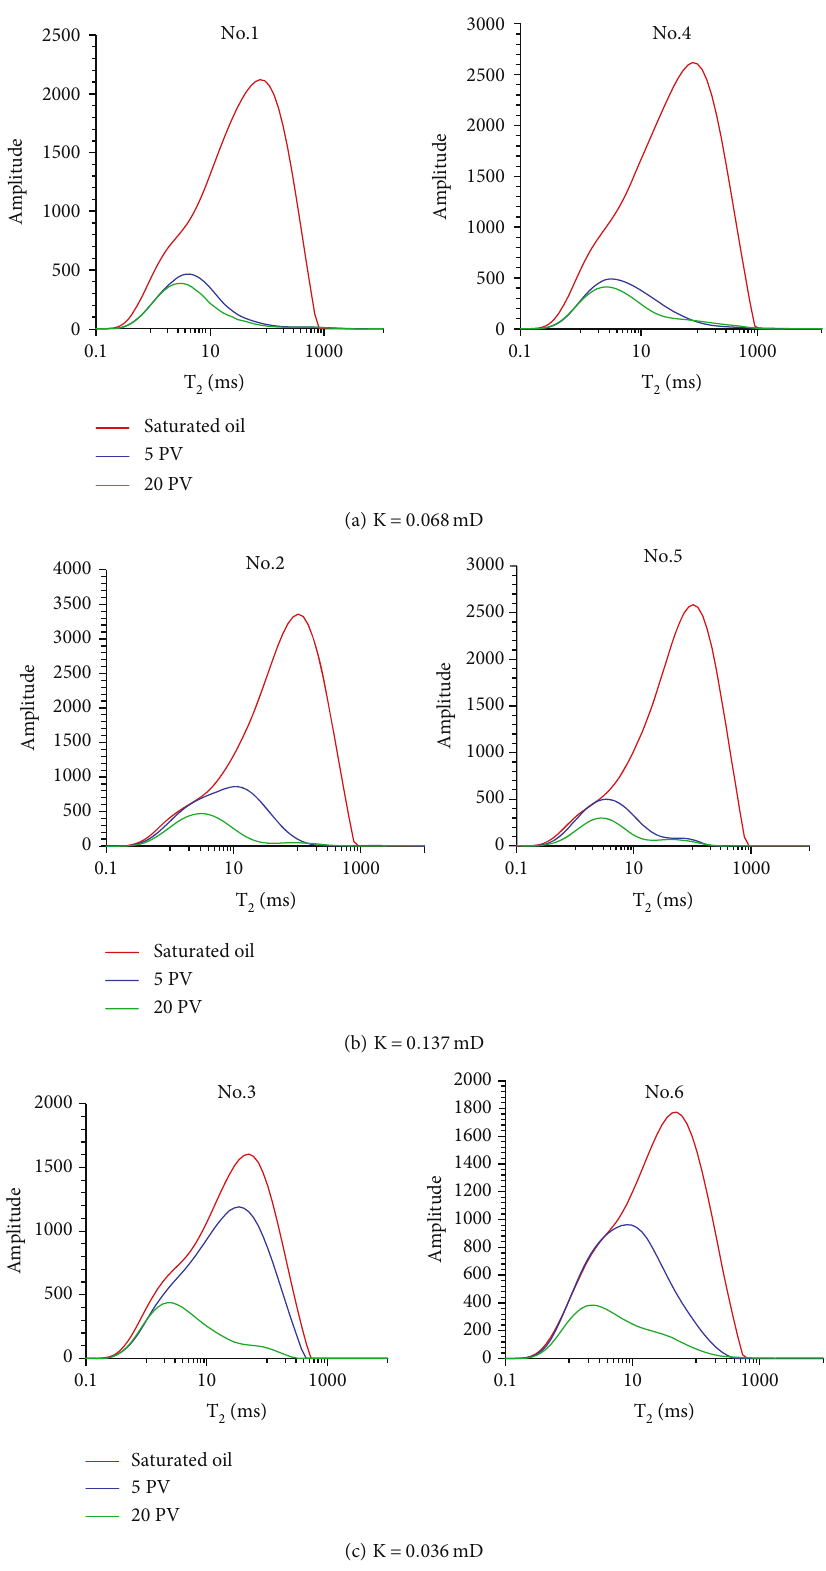
Figure 3: NMR spectra of rock samples during displacement with di ff erent